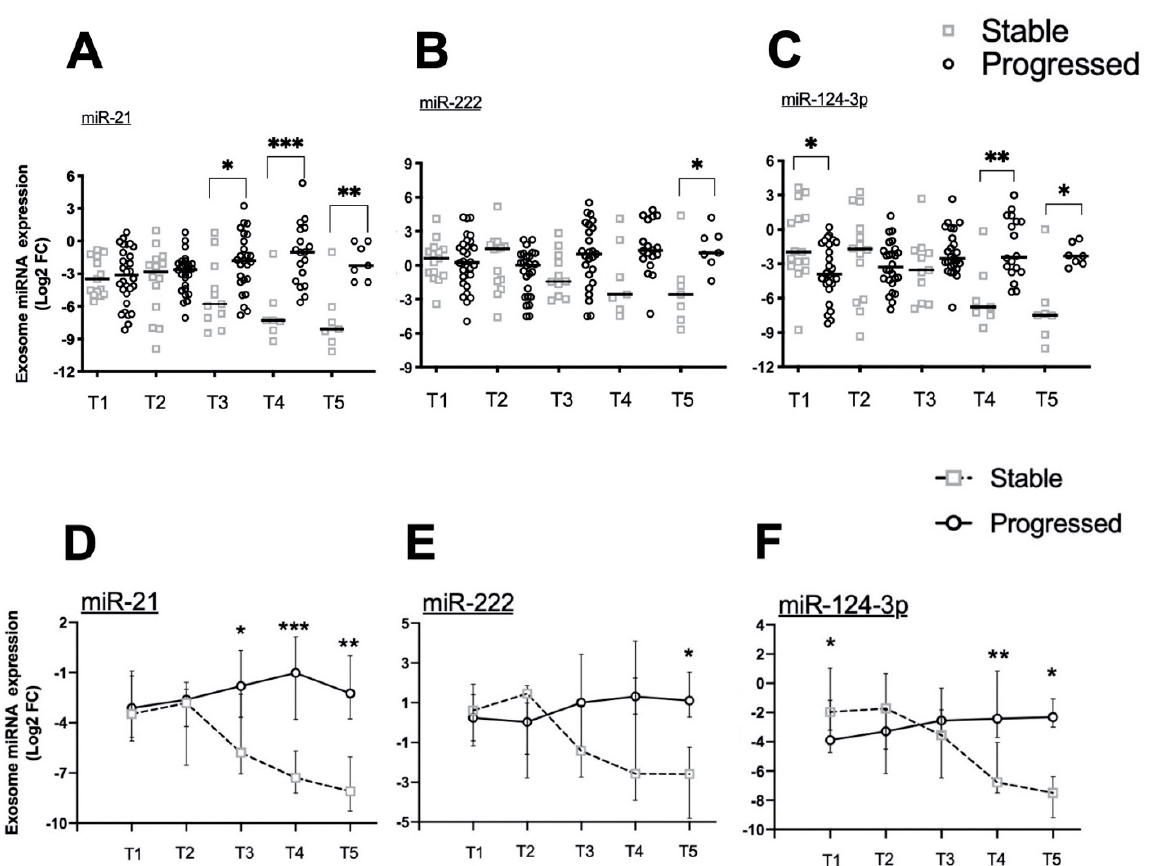
Figure 2. miRNA expression in serum exosomes at different time points in Stable and Progressed patients. miR-21 ( A ), -222 ( B ) and -124-3p ( C ) expression in serum exosomes was measured by real-time qPCR with TaqMan probes and normalized to U6 snRNA. Data are expressed as Log2FC. Comparisons between Stable and Progressed patients at each time point were analyzed with non-parametric U Mann–Whitney test. Differences were considered statistically significant as p < 0.05 (*), p < 0.01 (**), and p < 0.001 (***). Median miR-21 ( D ), -222 ( E ) and -124-3p ( F ) expression level in serum exosomes of Stable and Progressed patients was reported at each time point. Variations of miRNA expression levels at different time points were evaluated by ANOVA. Differences were considered statistically significant as p < 0.05 (*), p < 0.01 (**), and p < 0.001